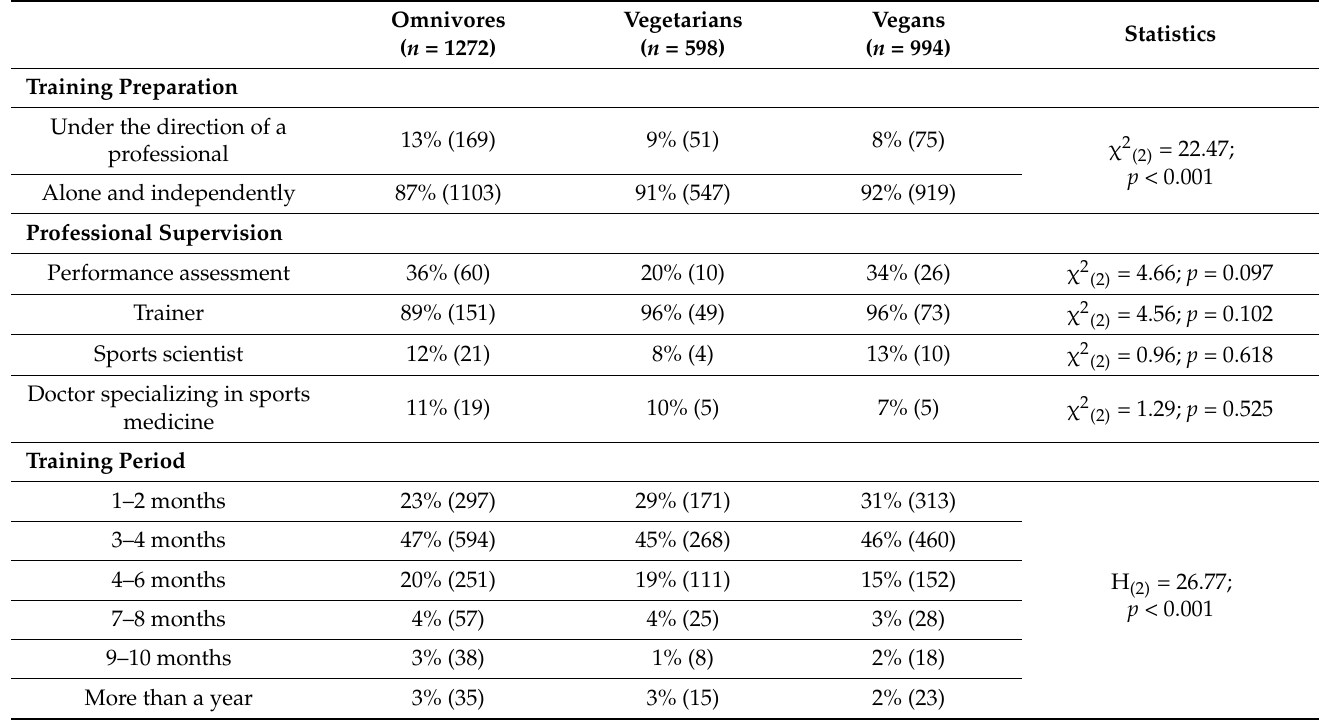
Table 5. Training type and time period displayed by dietary